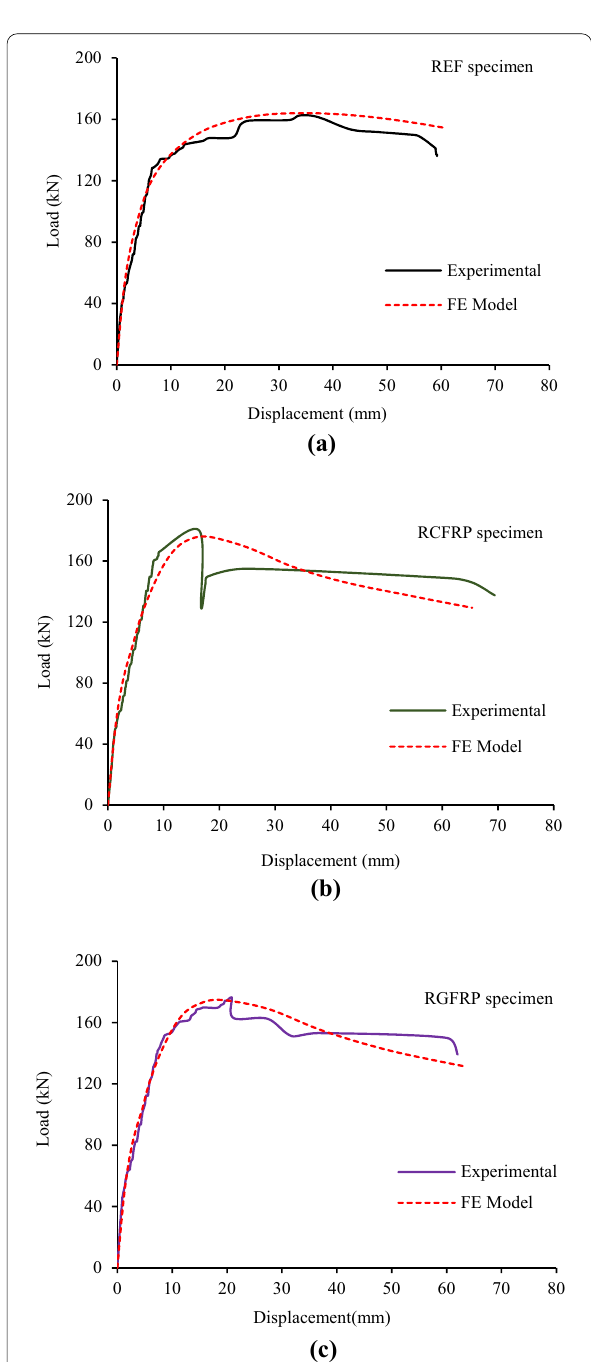
Fig. 25 Comparison between load–displacement curves of the simulated FE models and the tested specimens: a REF specimen, b RCFRP specimen, and c RGFRP